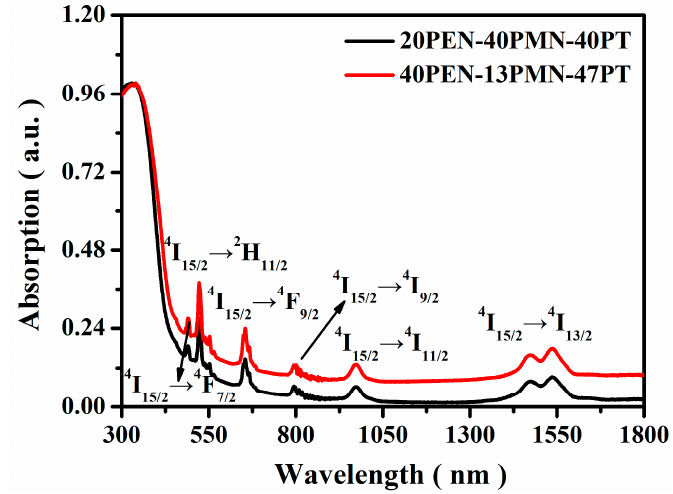
Figure 6. The UV–VIS–NIR absorption of PEN-PMN-PT crystals.